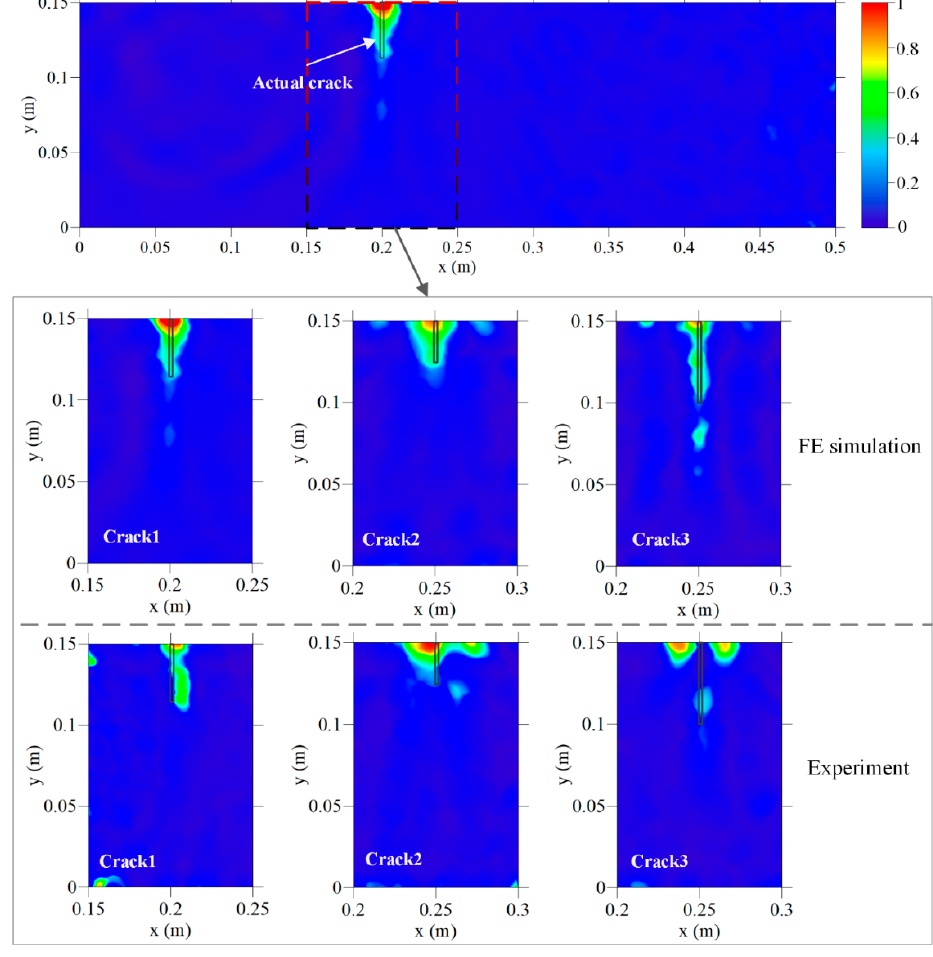
Figure 11. Imaging results of underwater crack by FE simulation and the experiment based on ˆ E avg ( x ) at a dominating frequency of 150 kHz.